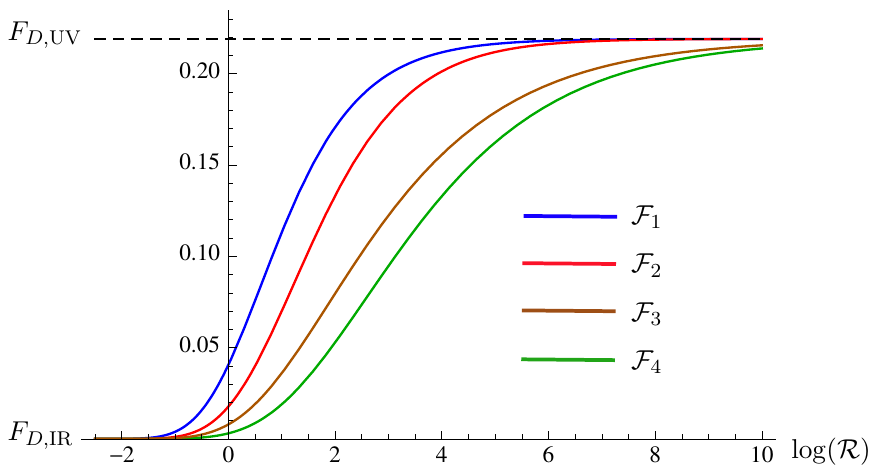
Figure 10. F 1 ; 2 ; 3 ; 4 given in (6.11){(6.14) vs. log( R ) for a theory of a free fermion on S 3 . The black dashed line indicates the value of F D; UV given in